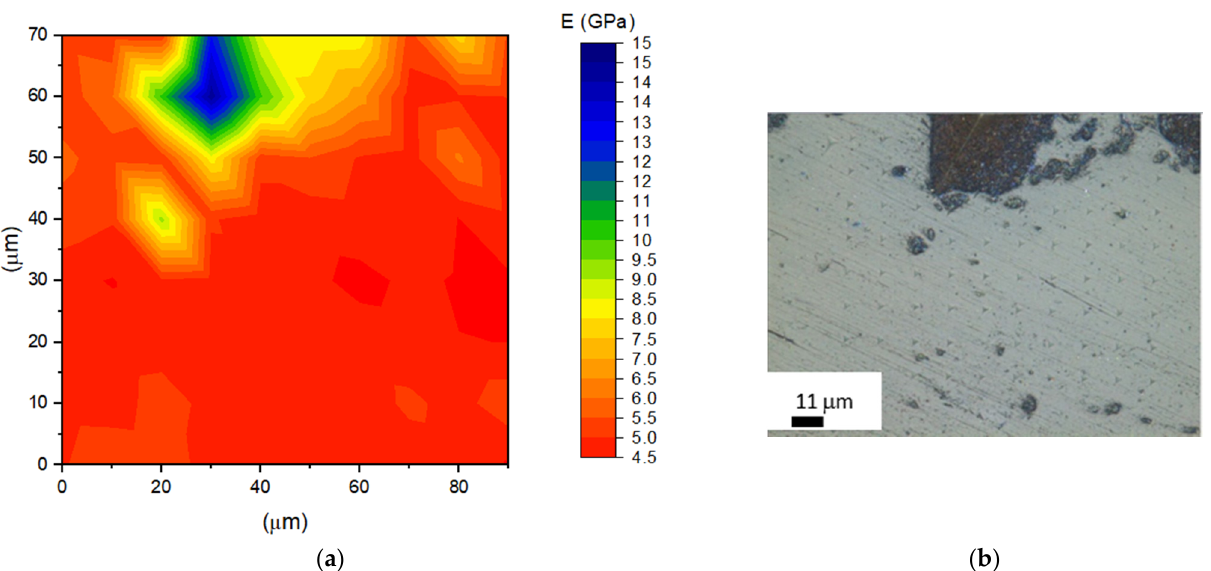
Figure 10. ( a ) Contour map showing the Young’s modulus distribution in PLLA9Mn as prepared; ( b ) OM picture of the area shown.